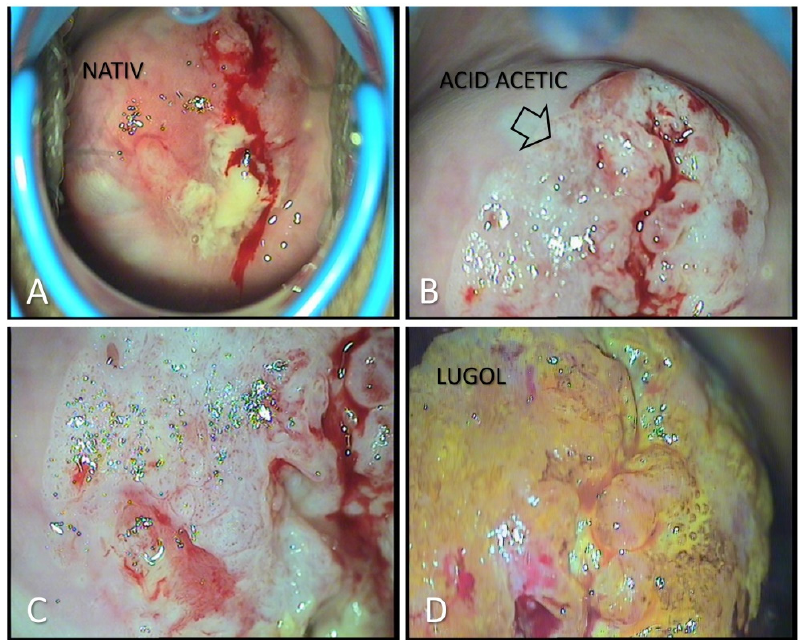
Figure 3. Colposcopic examination pleading for HSIL cervical lesion, with potential invasive carcinoma. ( A ): Native appearance: disorganized structure of the cervix, friable, easy bleeding to the touch; ( B ): After the application of acetic acid: extensive areas of aceto-white epithelium elevated and vessels with an increased caliber and active bleeding; ( C ): After applying acetic acid: association of multiple lesions, coarse lesions, associated with erosions and ulcerations; ( D ): Negative reaction when applying the Lugol solution, with areas of intense yellow coloration, such as “saffron” or “canary”.